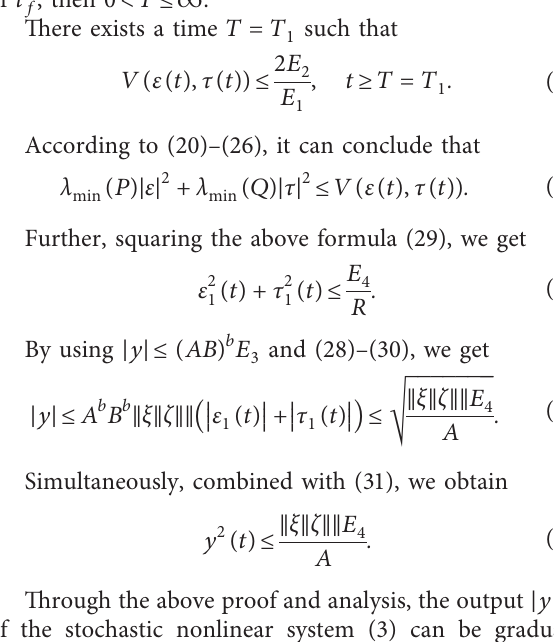
Figure 2: The trajectory of system state x